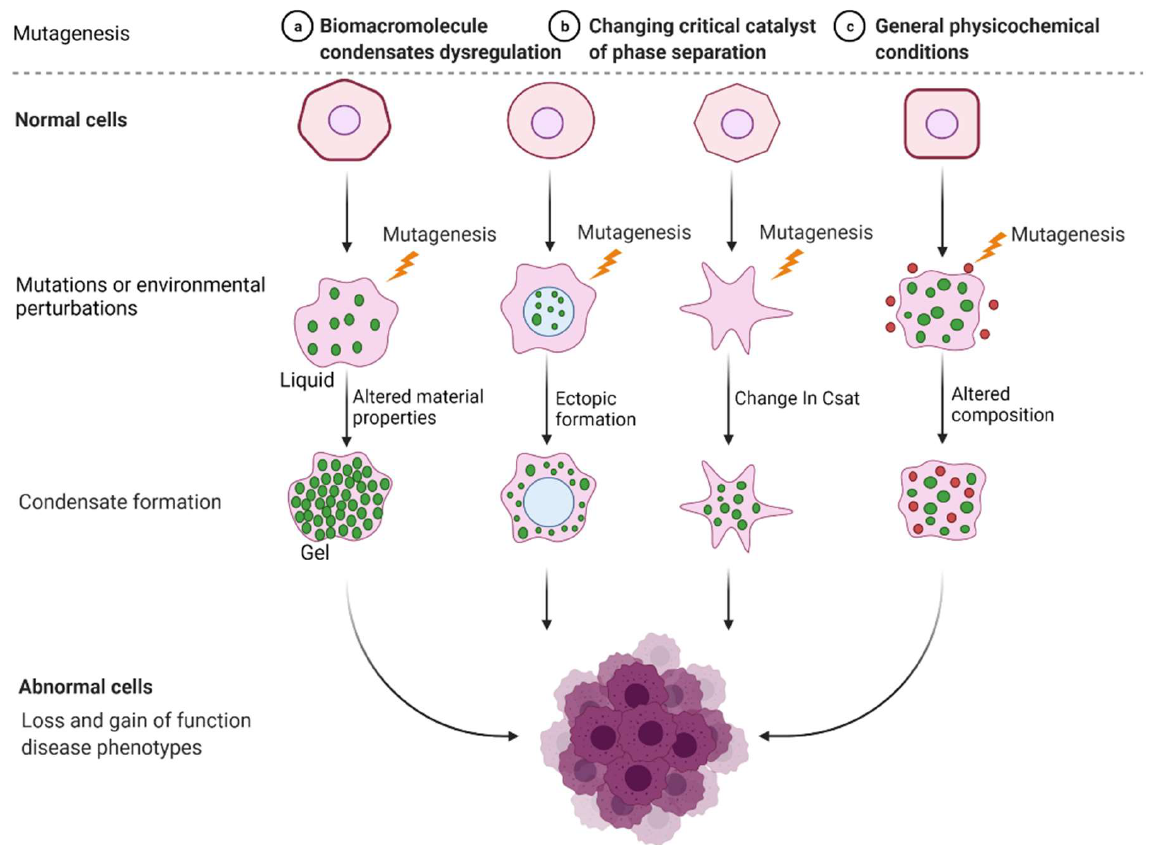
Figure 2. Mechanisms of abnormal phase separation in disease. Theoretical possibilities of how disease phenotypes arise from abnormal phase separation and condensate formation. Created with BioRender.com.